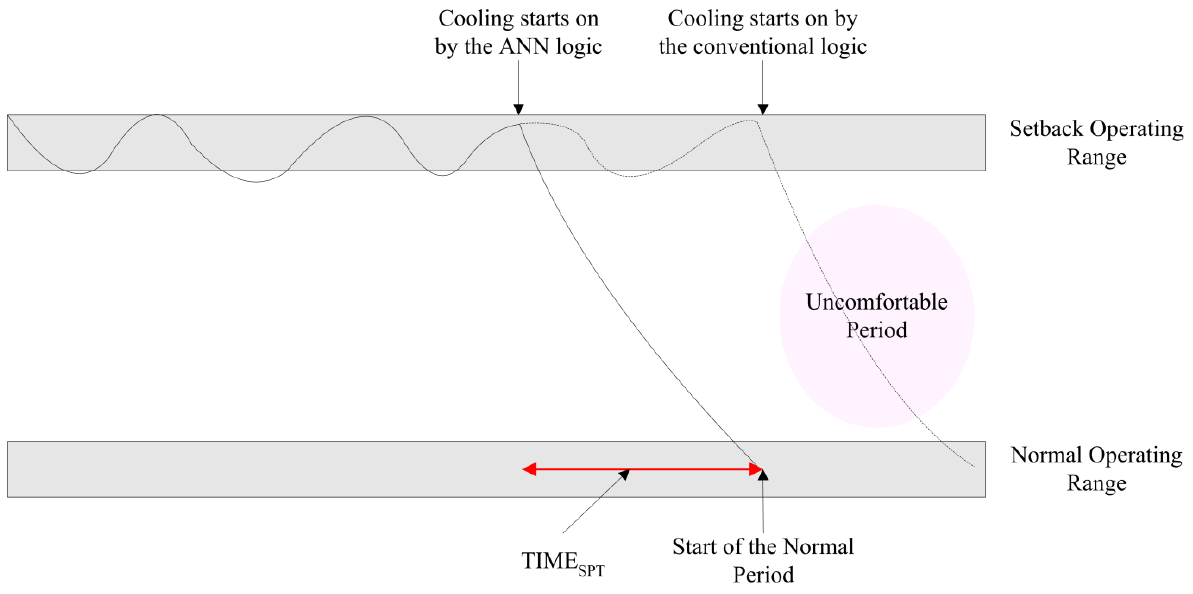
Figure 3. Conceptual comparison of the normal logic and the predicted